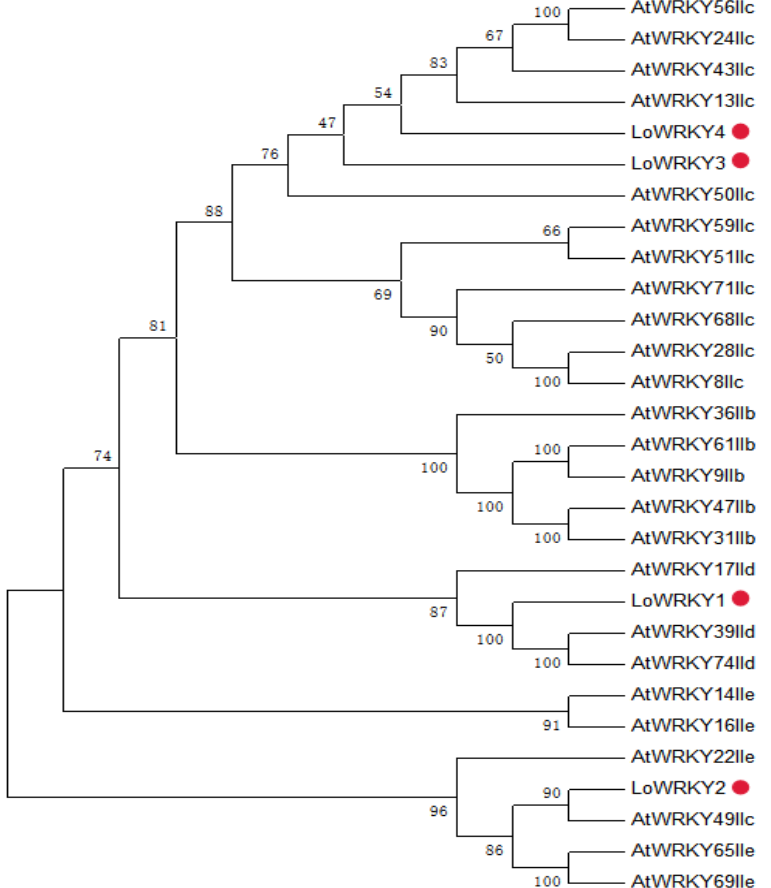
Figure 2. Phylogenetic trees of LoWRKY protein and Arabidopsis WRKY protein. Note: in the same evolutionary branch, the larger the value, the closer the genetic relationship. The genes added with red dots are those in larch.